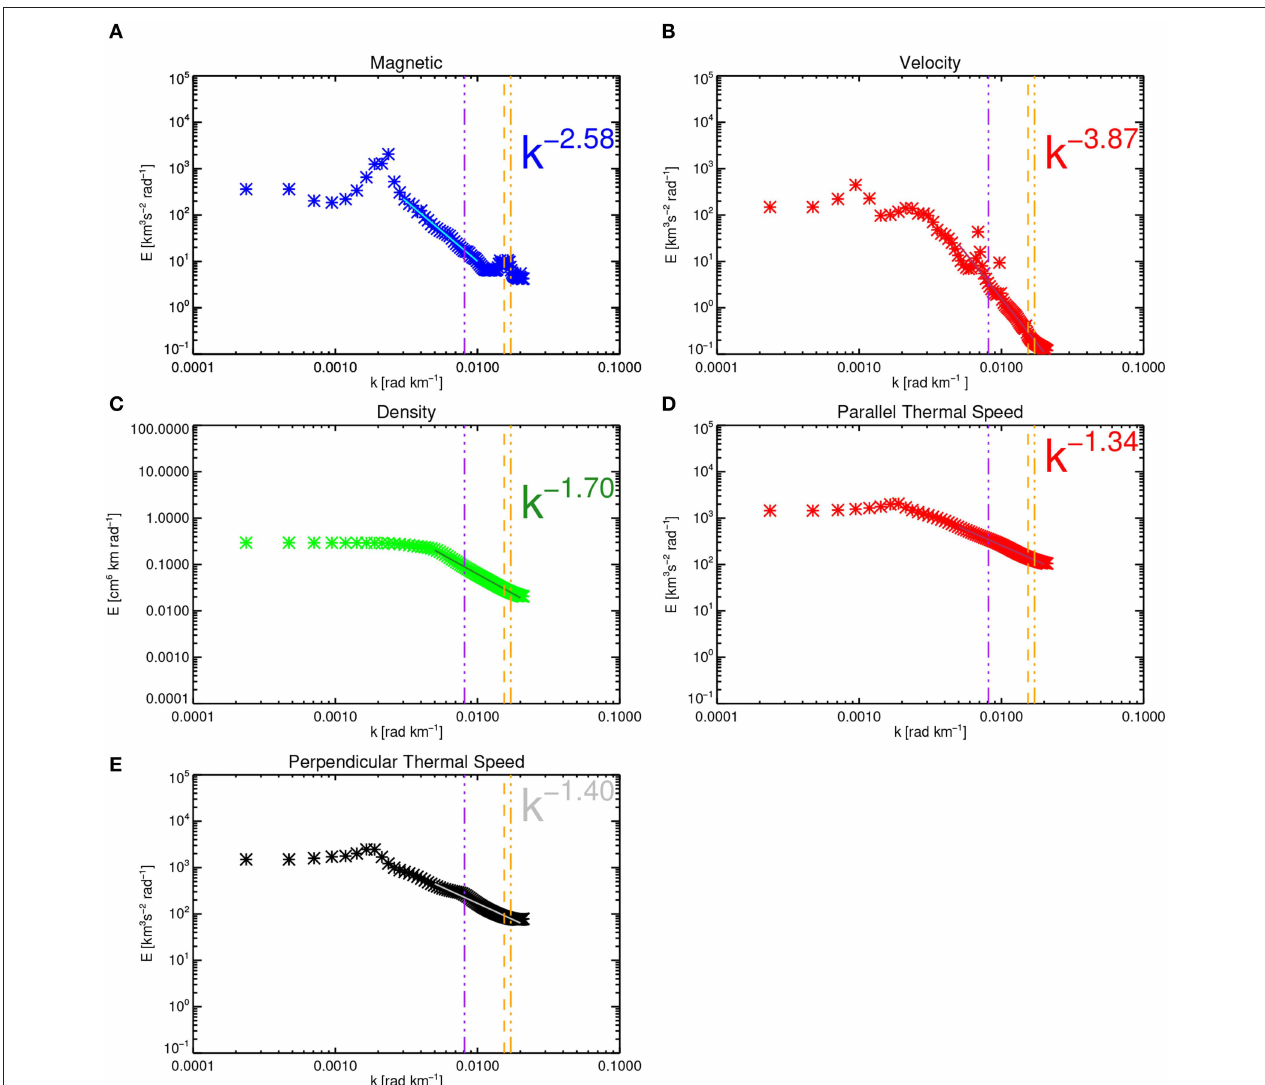
FIGURE 5 | Reduced one dimensional spectral densities, for (A) magnetic field (B) velocity, (C) density, (D) ion parallel thermal speed, and (E) ion perpendicular thermal speed. The orange vertical lines denote the ion inertial and Larmor radius while the purple vertical lines denote the length corresponding to the cyclotron frequency. The solid lines denote power law fits to the data and the obtained spectral index is indicated on the